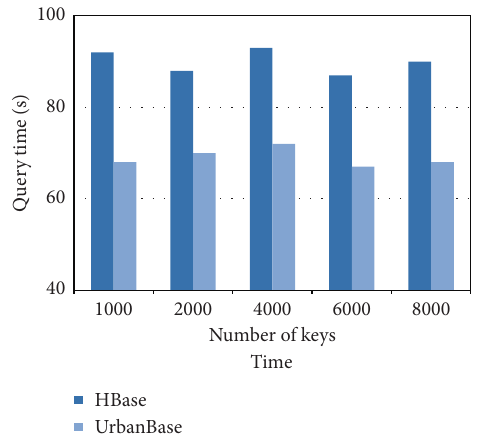
Figure 11: Query performance of HBase and